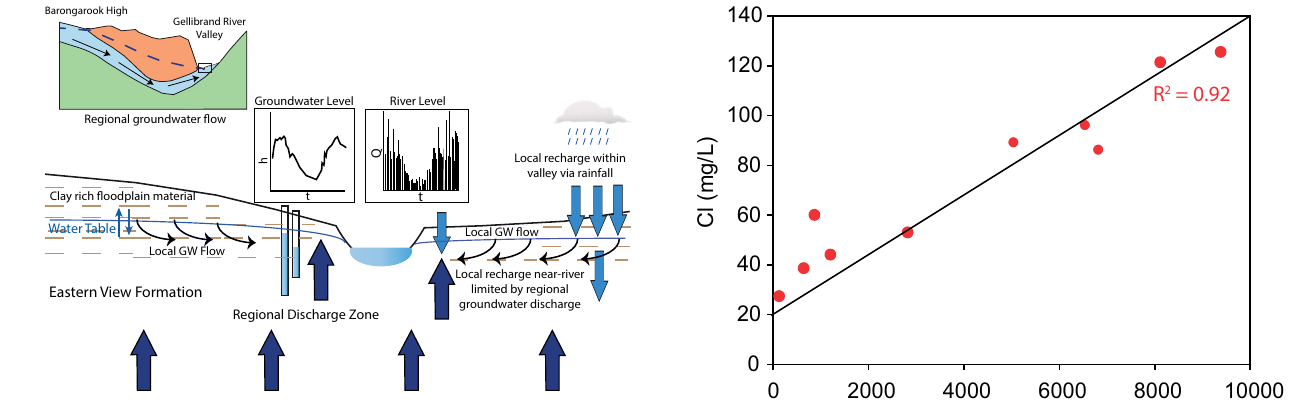
Figure 8. Groundwater flow conceptualization in the Gellibrand Valley. Though appreciable amounts of recharge are estimated from bore hydrographs and high river flows, the depth to which recharg- ing waters infiltrate into the Eastern View Formation (downward leakage) is limited by strong upward head gradients, and a flood- plain that consists of appreciable amounts of silt and clay.